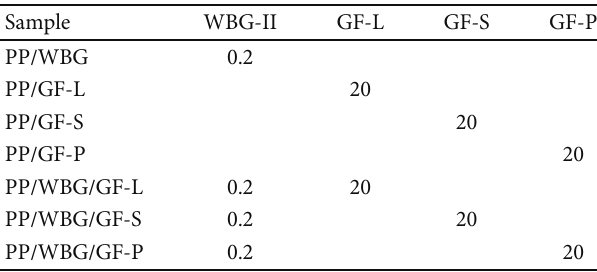
Figure 1: Particle size distribution glass fi ber powder. Table 1: Compositions of the samples (mass